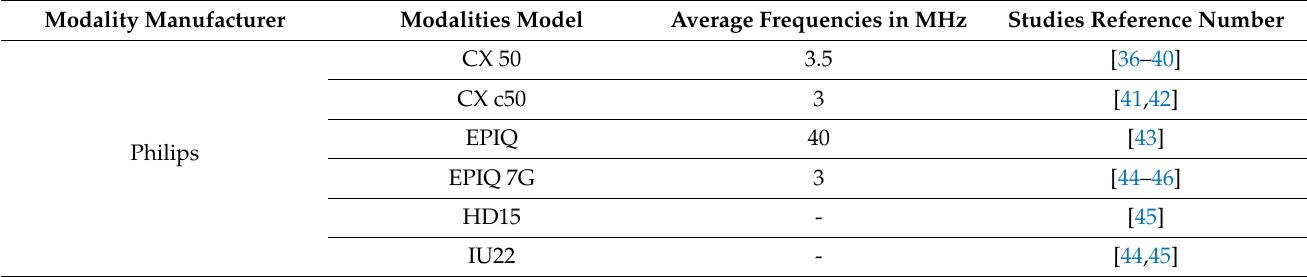
Table 3. Modalities and frequencies